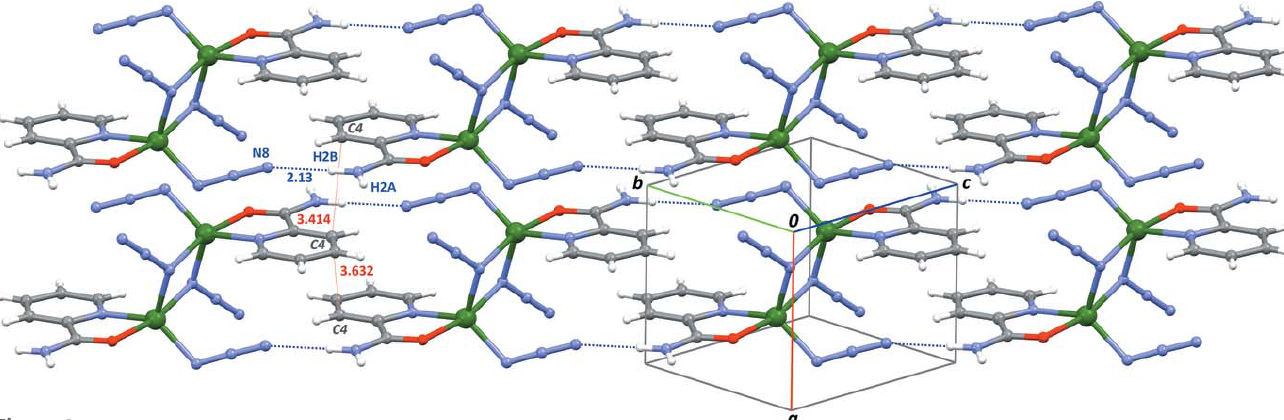
Figure 3 Part of the crystal structure of the title complex showing the arrangement of N—H (cid:3)(cid:3)(cid:3) N hydrogen bonds. The proximity between (cid:6) systems is reflected in the intermolecular C4 (cid:3)(cid:3)(cid:3) C4 separations, as measured using Mercury (Macrae et al. , 2020; thin red lines): C4 (cid:3)(cid:3)(cid:3) C4 i = 3.632 A˚ , and C4 i (cid:3)(cid:3)(cid:3) C4 ii = 3.414 A˚ [symmetry codes: (i) 1 (cid:2) x , 2 (cid:2) y , (cid:2) z ; (ii) (cid:2) 1 + x , y , z ]. The strongest intermolecular hydrogen bond (Table 2, entry 2) is represented by blue dotted lines.